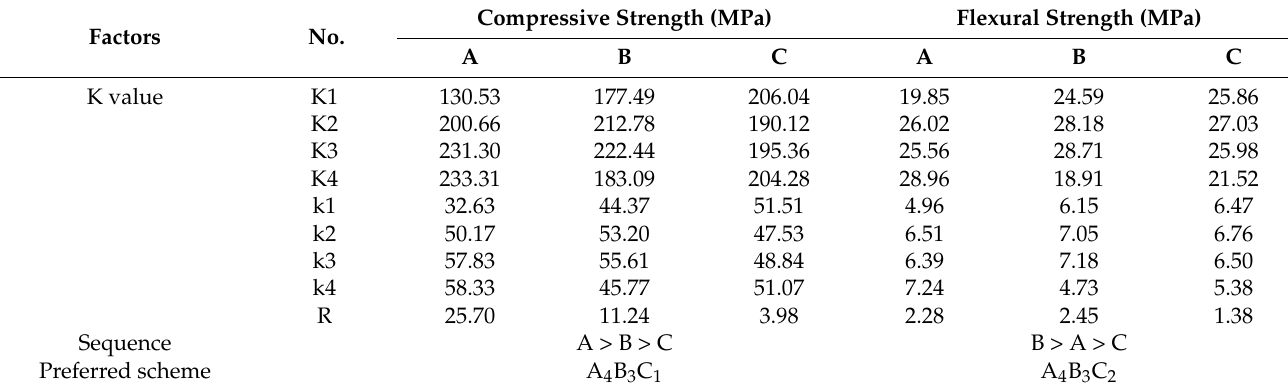
Table 6. Analysis results of the polar differences in the mechanical properties of the Na-based geopolymers at 28